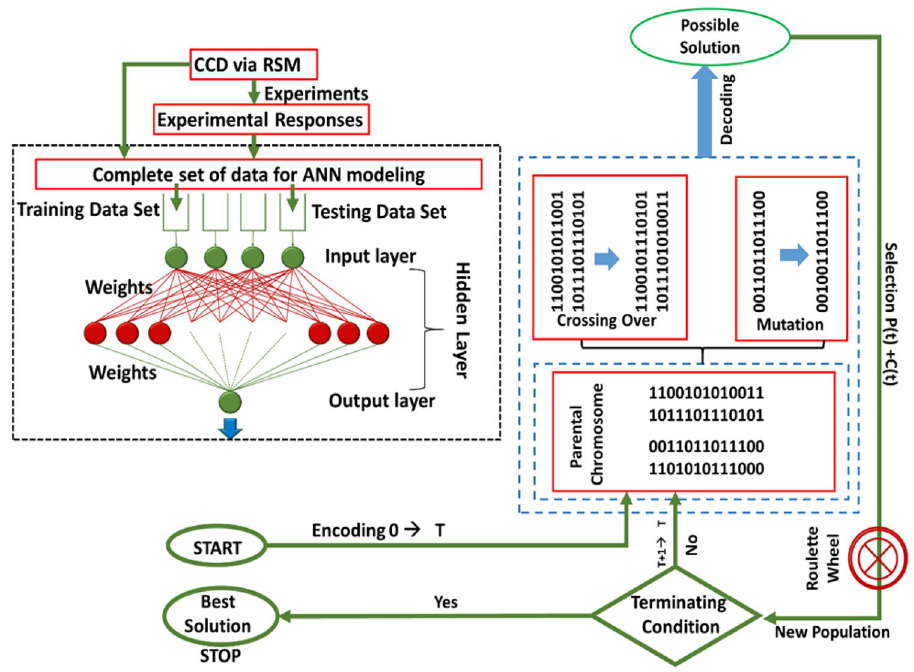
Figure 1. Schematic representation of simulated hybrid model (RSM-ANN-GA) and its working